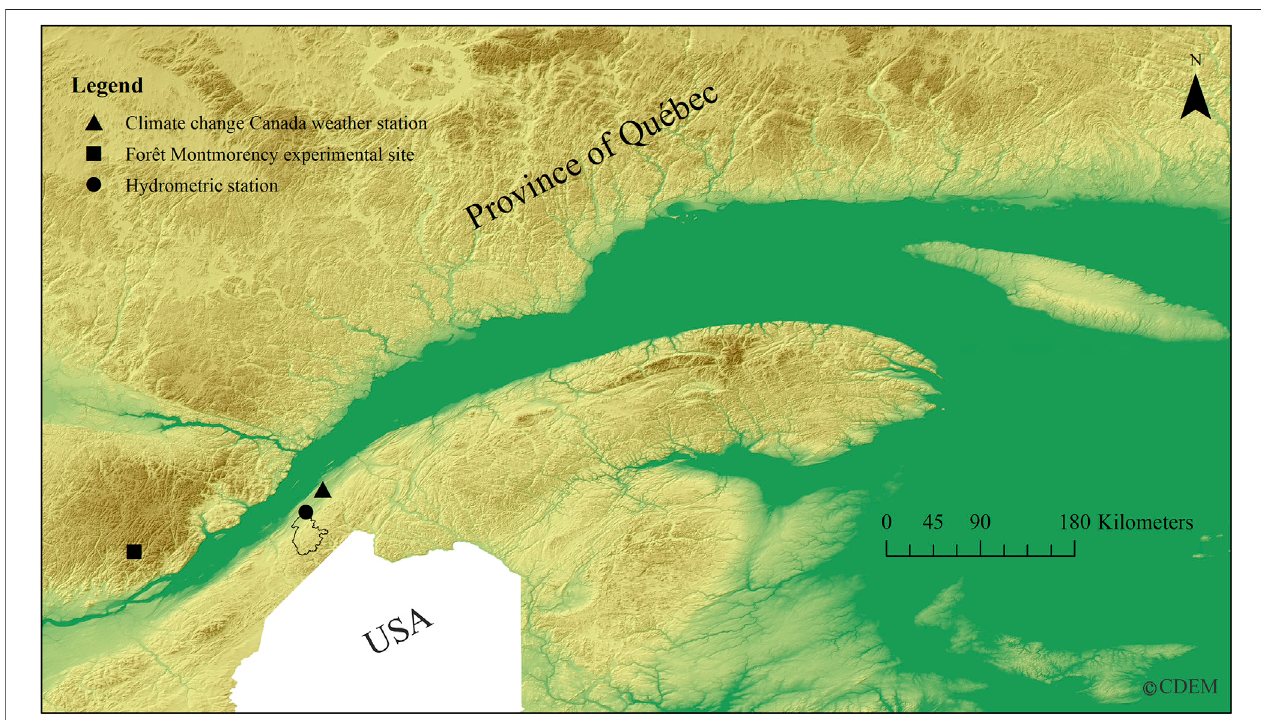
FIGURE 2 | Du Loup catchment,